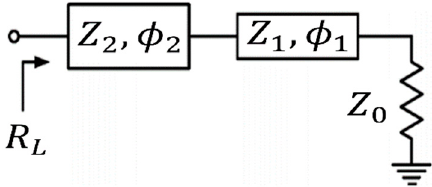
Figure 5. Dual-band global matching network.